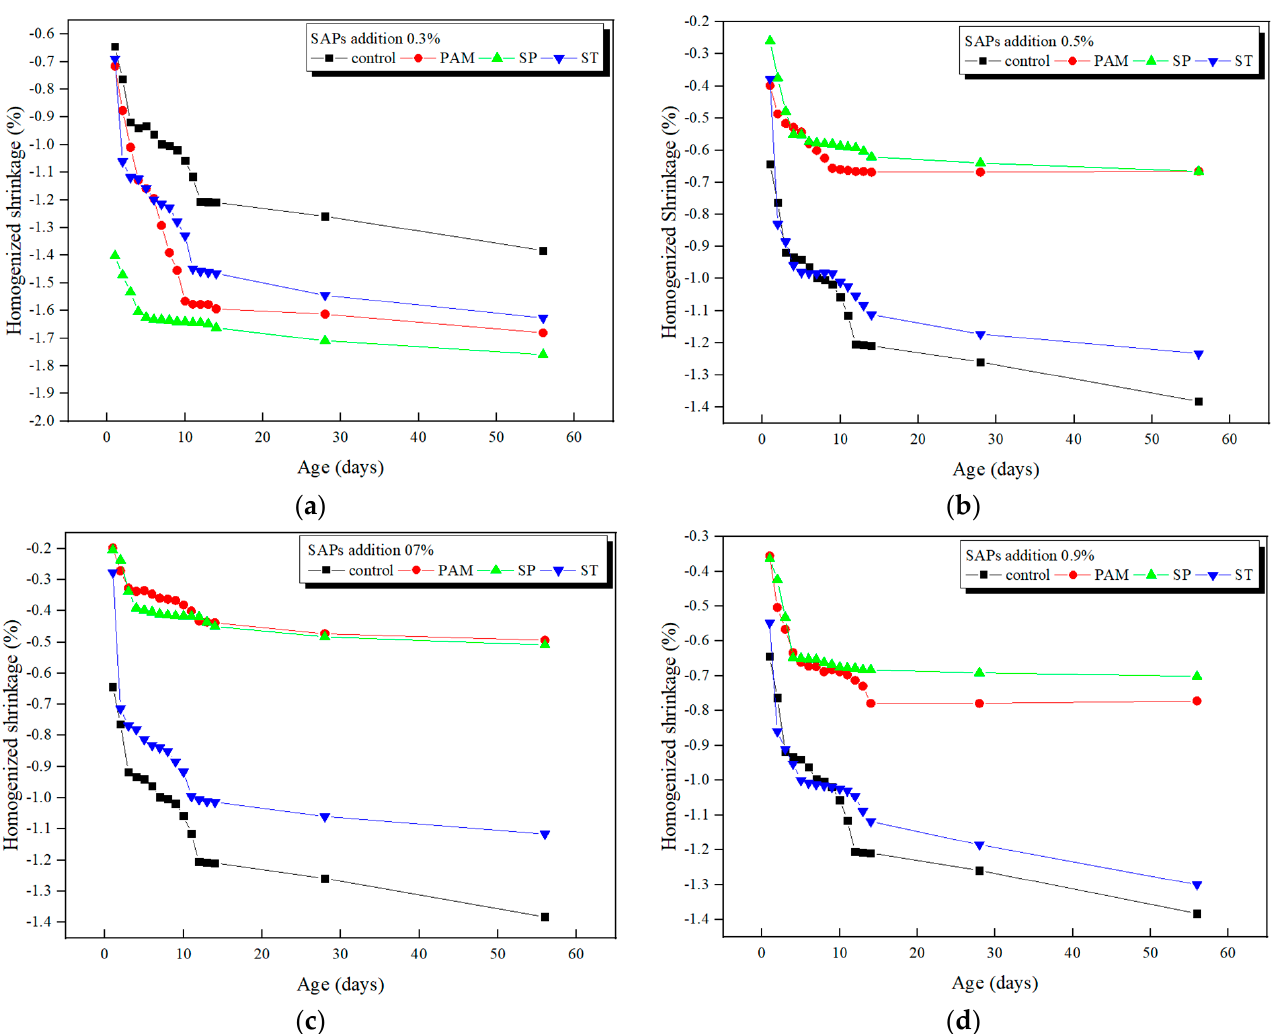
Figure 7. Comparison of drying shrinkage with different SAP contents added. ( a ) Changes in length from drying shrinkage when 0.3% of a given polymer material was added. ( b ) Changes in length from drying shrinkage when 0.5% of a given polymer material was added. ( c ) Changes in length from drying shrinkage when 0.7% of a given polymer was added. ( d ) Length changes from drying shrinkage when 0.9% polymer material was added.